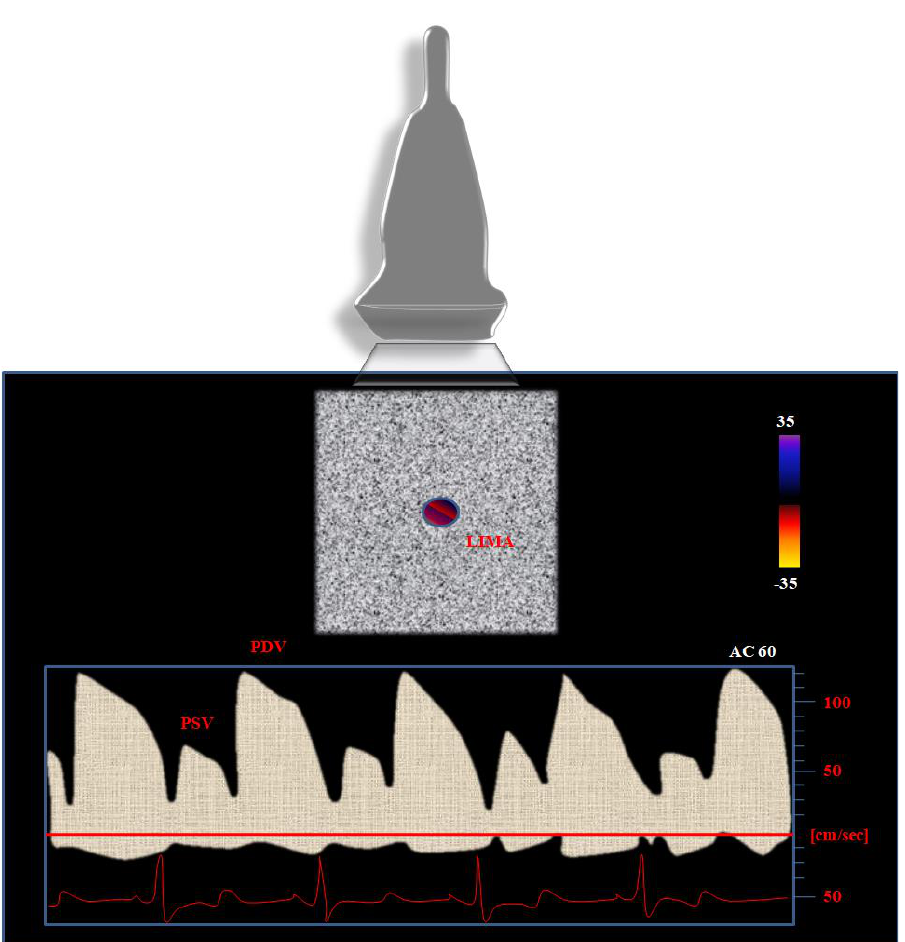
Figure 1. Left internal mammary artery (LIMA) pulsed-wave color Doppler flow aspect from the left parasternal window: the Doppler profile points out the peak systolic (PSV) and diastolic (PDV) velocities.